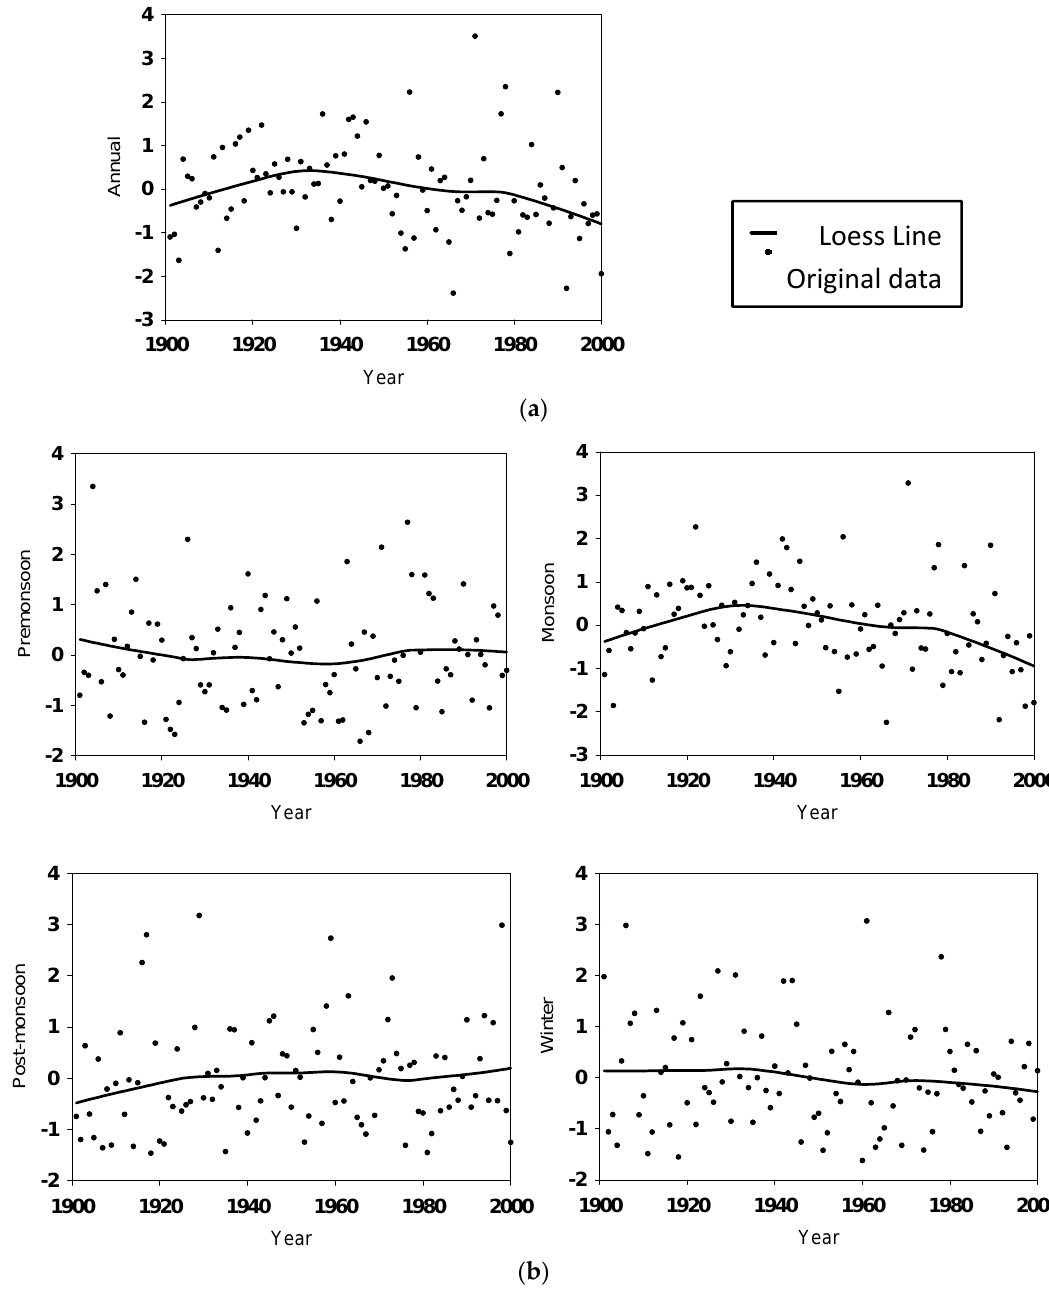
Figure 3. Loess regression curve of ( a ) Annual and ( b ) Seasonal rainfall.